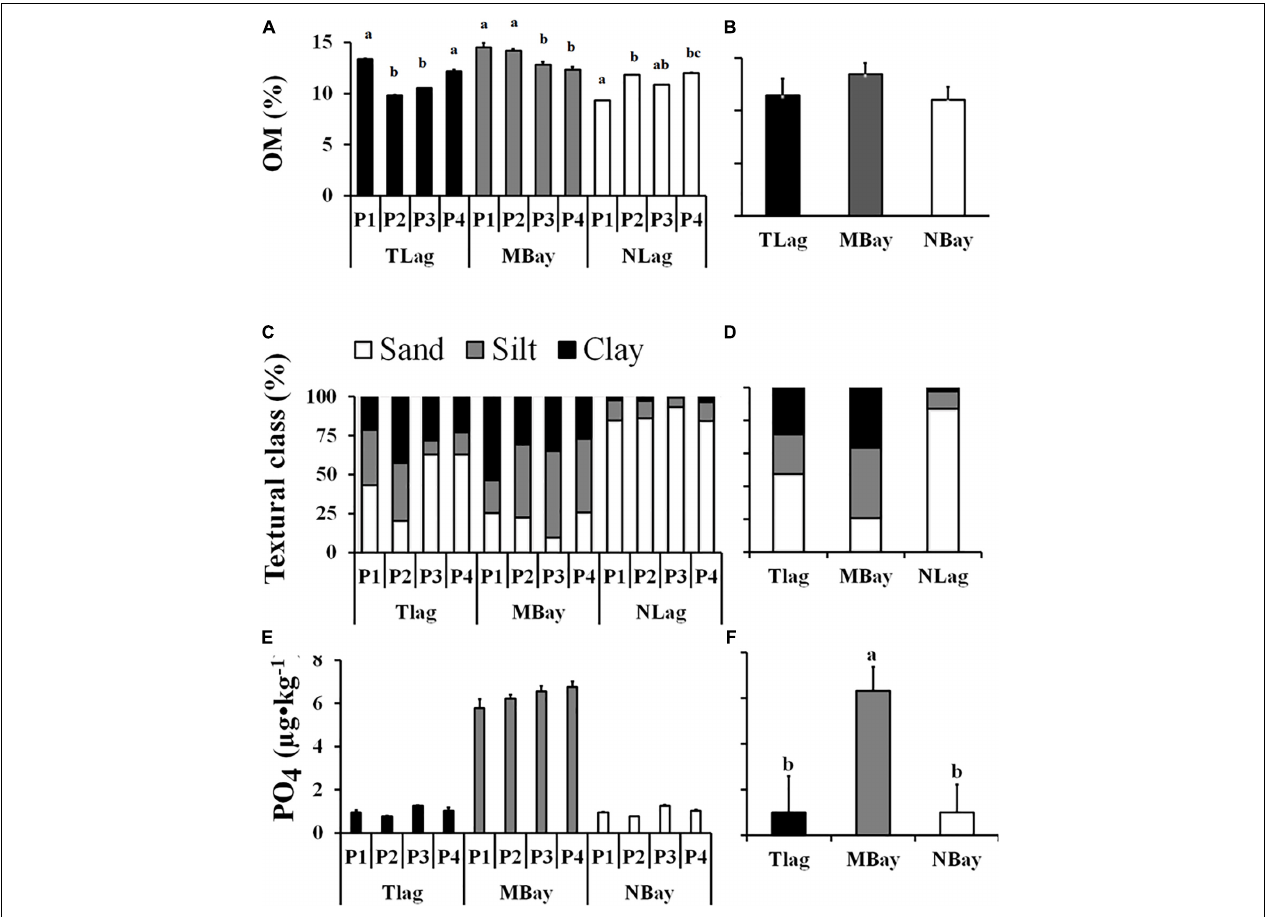
FIGURE 3 | Organic matter (OM) concentration (A,B) , PO 4 (C,D) , and textural classes (E,F) (average ± SD) in sediments from MBAY, NLAG, and TLAG. Different letters show significant statistical differences ( p ≤